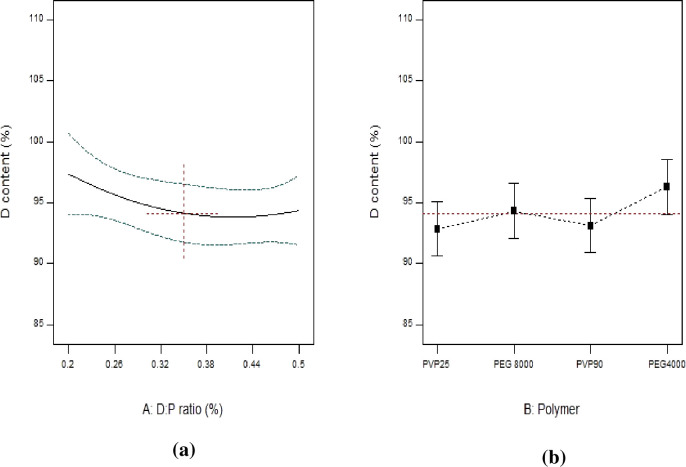
Line plots for the effect of formulation variables on DC %.